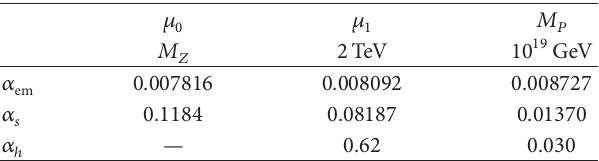
Table 2: The QED, QCD, and QHD fine structure constants 𝛼 𝑖 = /4𝜋 at the 𝑍 -pole scale 𝜇 = 𝑀 𝑔 2 0 𝑍 , at an intermediate high energy 𝑖 scale 𝜇 1 = 2 TeV (around the haplon continuum threshold), and at the Planck energy 𝑀 𝑃 ∼ 1.2 × 10 19 GeV, for the 𝑆𝑈(2) ℎ chiral gauge group of QHD. 𝜇